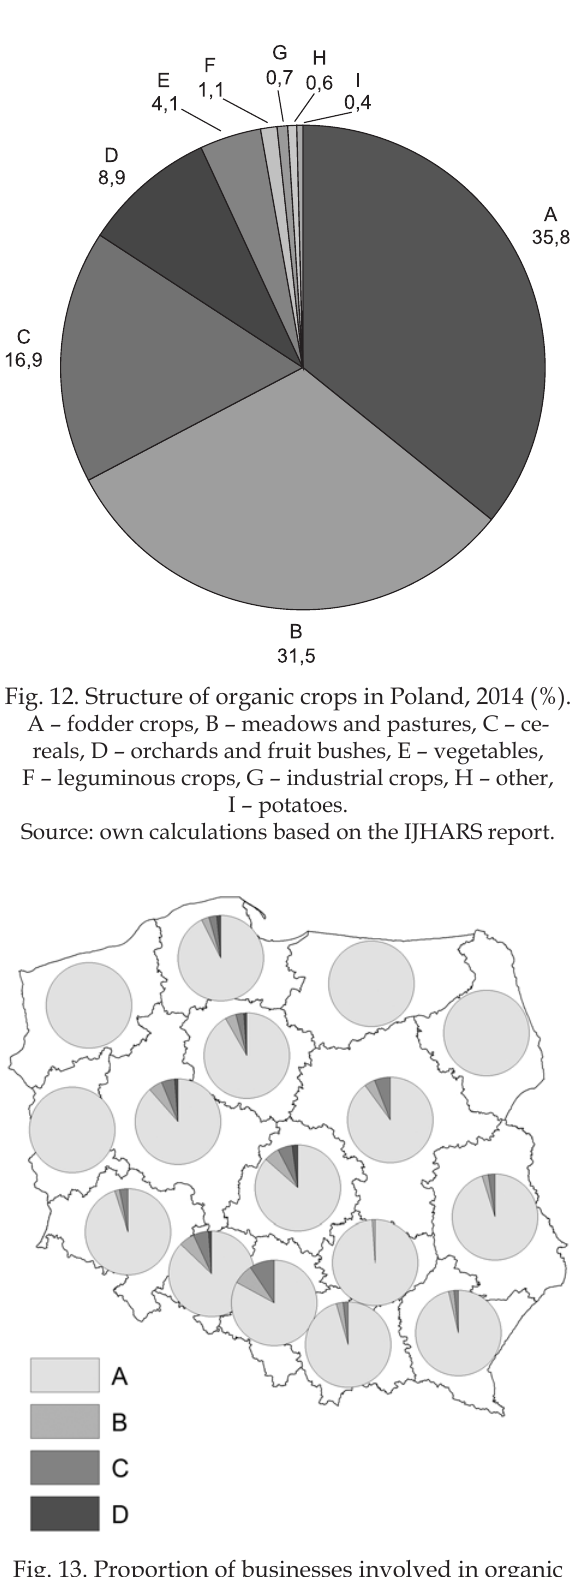
Fig. 13. Proportion of businesses involved in organic agriculture in Poland,